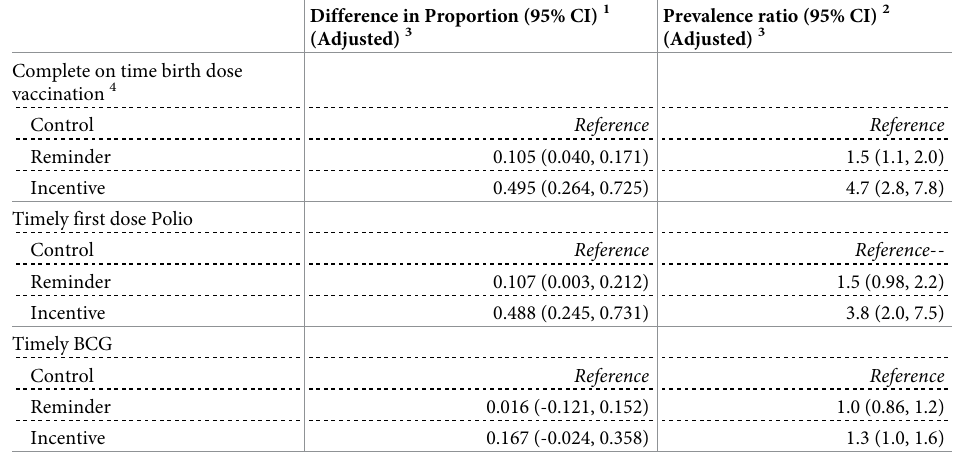
Table 3. Effect of GEVaP intervention on timely vaccination of first Polio and BCG vaccination [Intent-to-treat] (N =